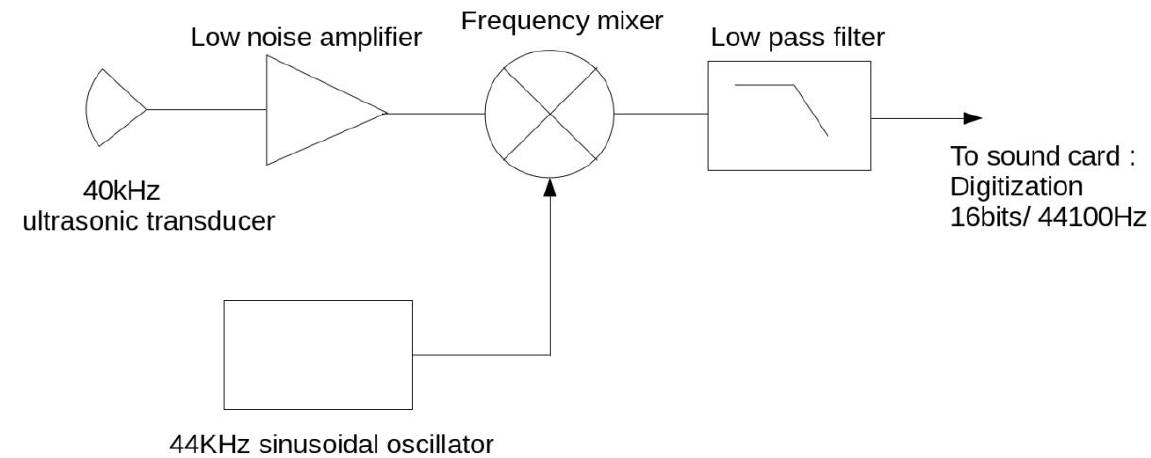
Figure 2. Block diagram of the receiver